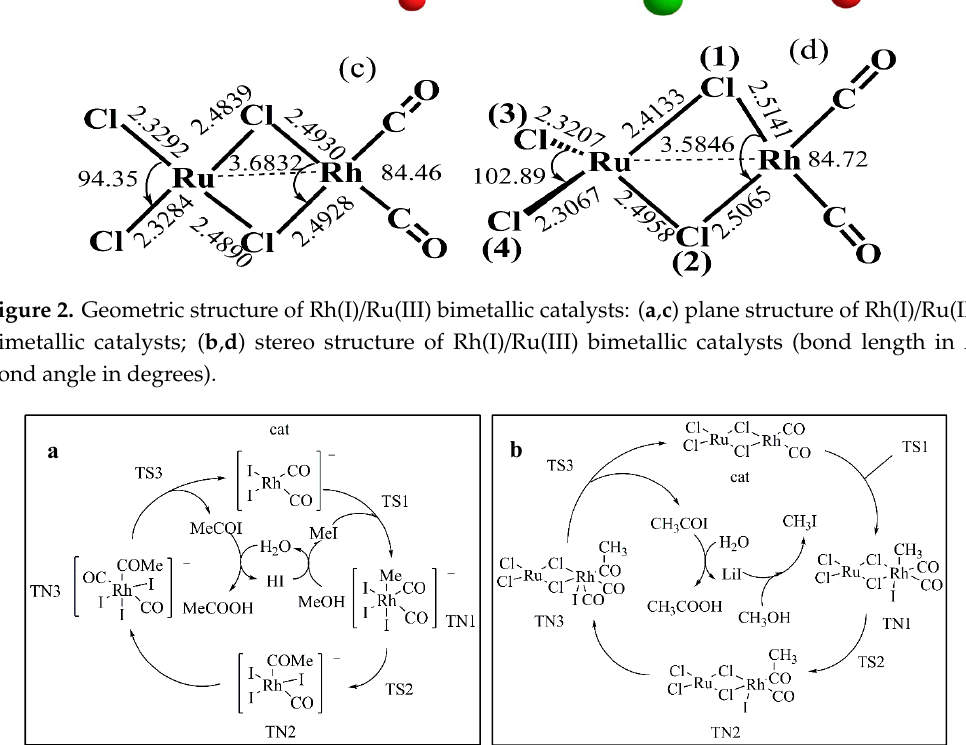
Figure 2. Geometric structure of Rh(I)/Ru(III) bimetallic catalysts: ( a , c ) plane structure of Rh(I)/Ru(III) bimetallic catalysts; ( b , d ) stereo structure of Rh(I)/Ru(III) bimetallic catalysts (bond length in Å, bond angle in degrees).